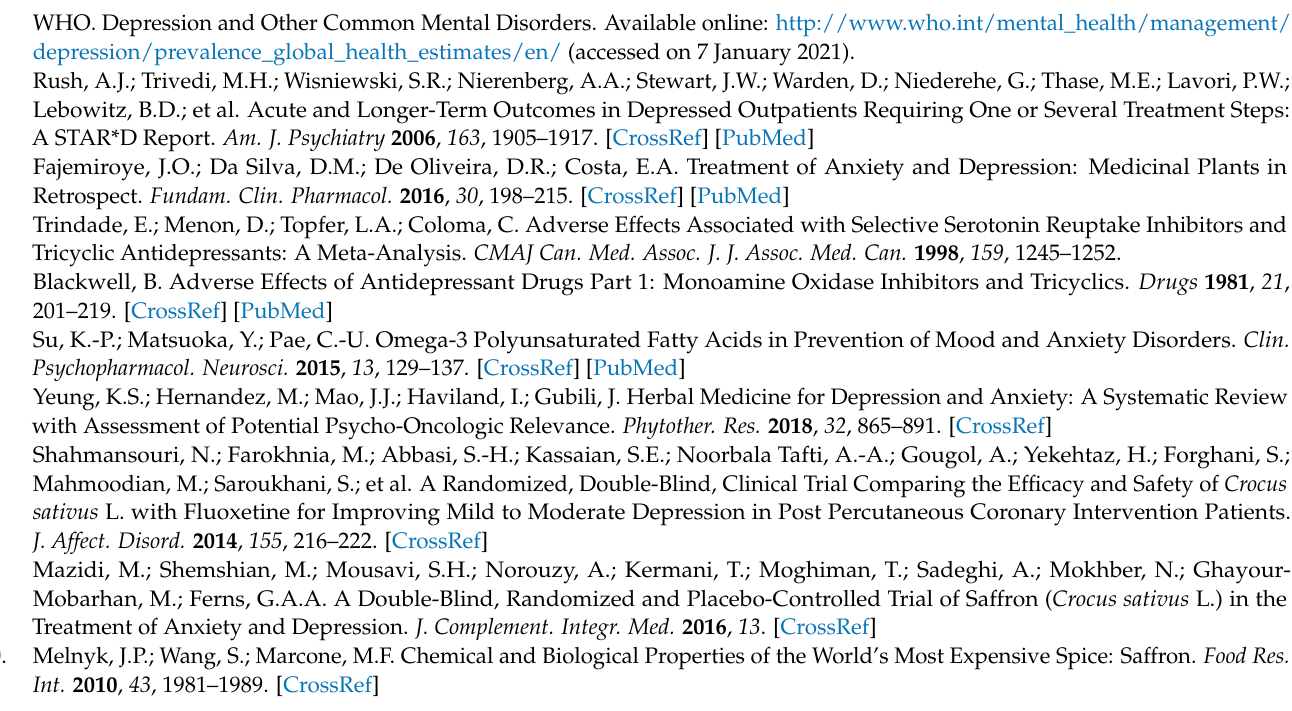
Figure S2: Effect of chronic oral administration of Safr’InsideTM (6.25 mg/Kg) on anxiety-like behavior measured in the marble burying test (MBT) on mice chronically exposed to Unpredictable Chronic Mild Stress